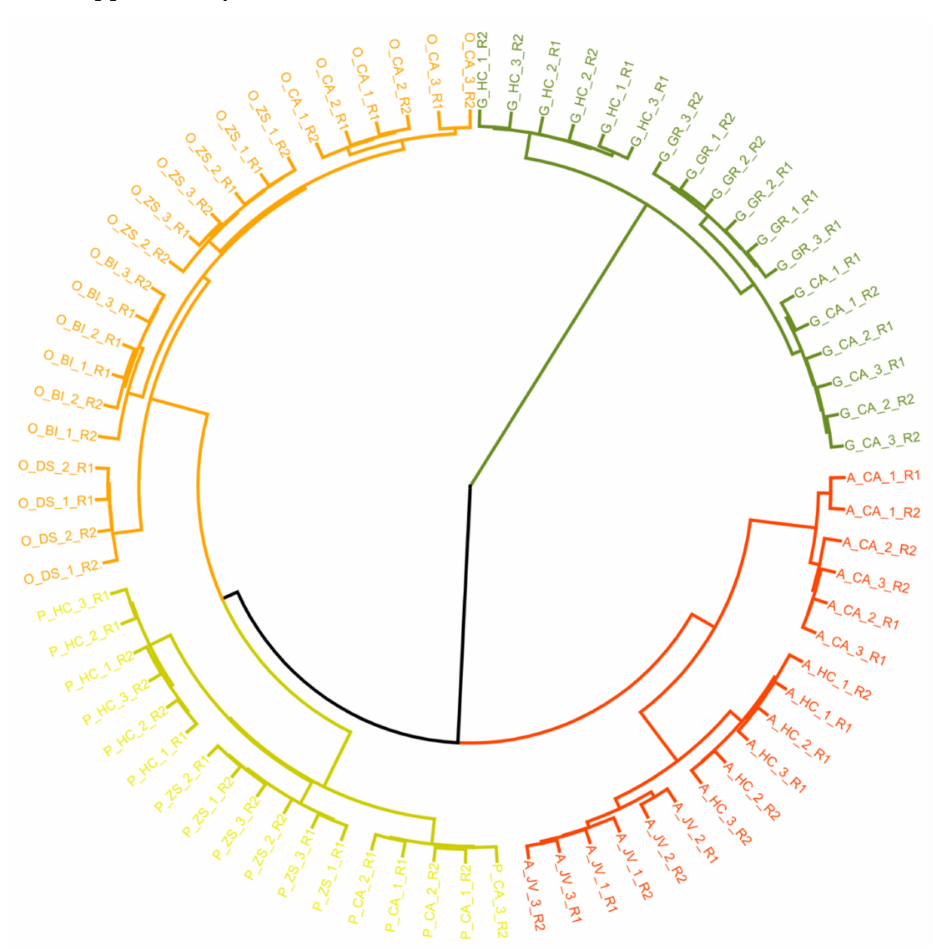
Figure 1. Dendrogram from HCA (hierarchical cluster analysis) using the Manhattan distance and average method for all FT-IR spectra of pure juices (D 76 × 540 ). Samples are colored according to juice type: P for pineapple (yellow), G for grape (dark green), A for apple (red), and O for orange